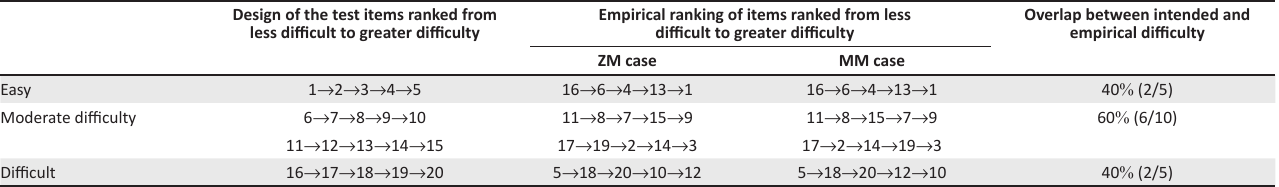
TABLE 4: Comparison of intended and empirical difficulty, under ZM and MM methods. Design of the test items ranked from less difficult to greater